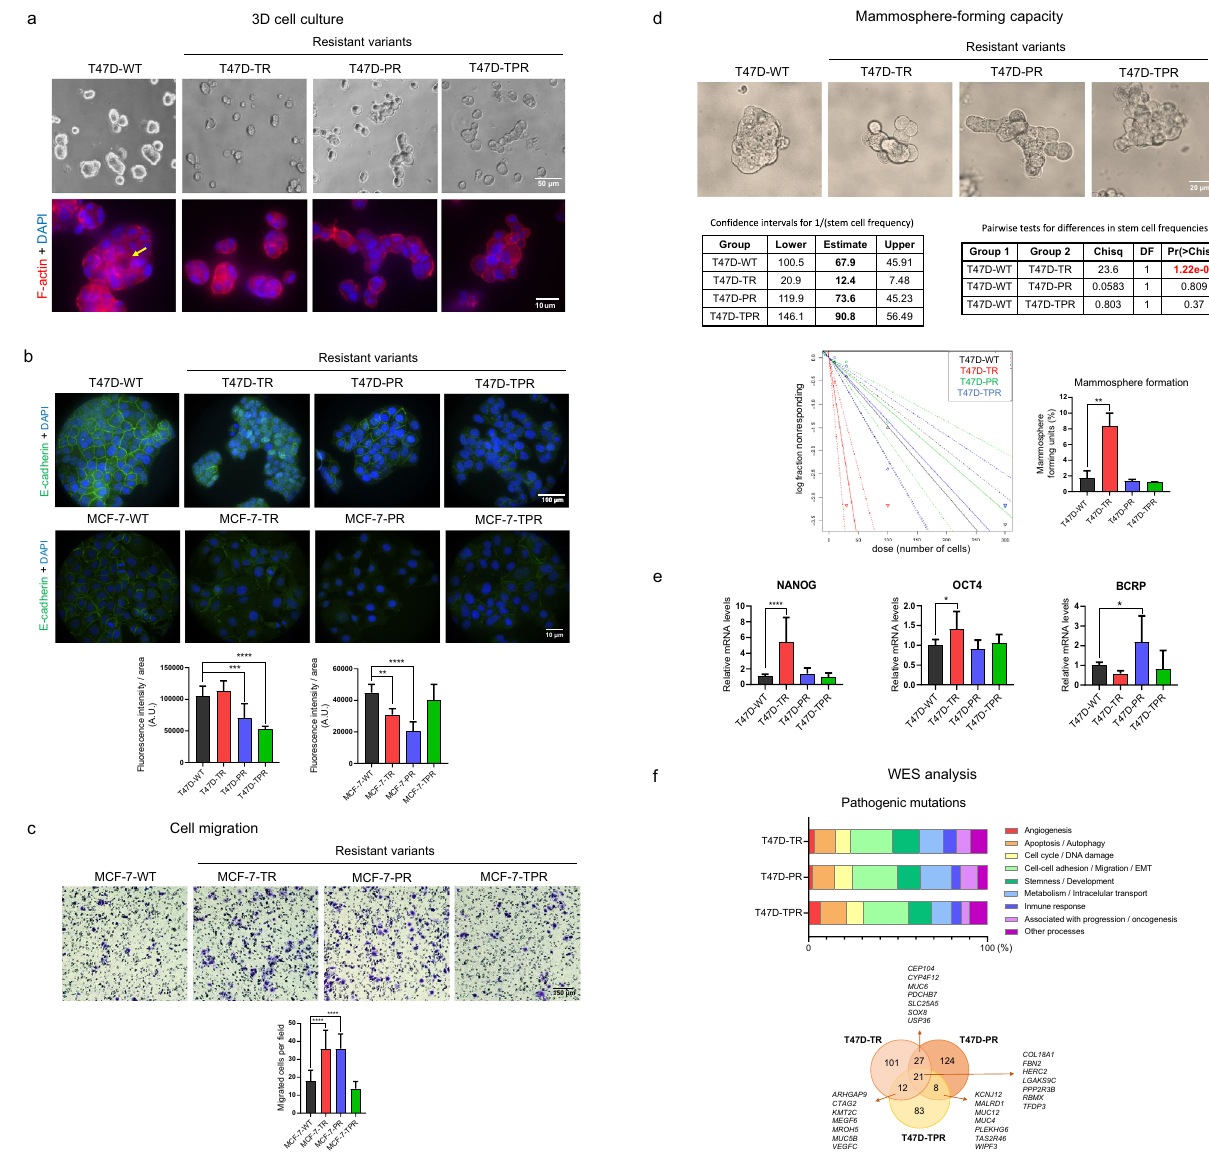
Figure 2. The resistant cells exhibit an altered phenotype. ( a ) 3D cultures. T47D cells were cultured on Geltrex for 48 h. 3D cultures were stained for F-actin with phalloidin (red), and nuclei were counterstained with DAPI (blue). Some of the T47D-WT spheroids exhibited a lumen (yellow arrow). ( b ) Expression and localization of E-cadherin. Confocal microscopy images of immunofluorescence staining for E-cadherin (green). Nuclei were counterstained with DAPI (blue). **p < 0.01, ***p < 0.001. Data represent mean ± SD, one-way ANOVA followed by Dunnett’s test (independent replicates n = 2, with 10 analyzed fields in each group). Since resistant cells are bigger than wild type cells, fluorescence intensity was adjusted to cell area. ( c ) Cell migration. Transwell migration assays were performed by seeding MCF-7 cells onto 8 µm-pore inserts in the presence of a serum gradient. After 24 h, cells that passed through the insert and attached to the other side were quantified. ***p < 0.001. Data represent mean ± SD, one-way ANOVA followed by Dunnett’s test (independent replicates n = 3, with 4 experimental replicates in each group). ( d ) Mammosphere-forming capacity. Mammosphere formation assays and Extreme limiting dilution assay were performed. Sphere formation frequencies were compared using the ELDA web tool (left). The number of cells seeded per well versus the logarithmic fraction of wells without any detected spheres was plotted (middle). Trend lines represent the estimated active cell frequency, dotted lines show the 95% confidence interval. Percentage of sphere-forming units was plotted according to % = 1/Frequency × 100 (right). **p < 0.01. Data represent mean ± SD, one- way ANOVA followed by Dunnett’s test (independent replicates n = 2, with 6 experimental replicates in each group). ( e ) Expression of stemness markers. mRNA levels of NANOG, OCT4 and BCRP were measured by qRT-PCR. Expression levels were normalized to the GAPDH expression for each variant. *p < 0.05, ****p < 0.0001. Data represent mean ± SD, one-way ANOVA followed by Dunnett’s test (independent replicates n = 3, with 3 experimental replicates in each group). ( f ) Pathogenic mutations in T47D-resistant cells. Mutations that were not present in the parental cells were filtered by potential pathogenicity using REVEL, SIFT, Polyphen2 and CLNSIG predictors. Top: Mutated genes were grouped according to their function or the cellular processes they are involved in. Bottom: Venn Diagram showing the number of pathogenic mutations in the resistant cells and some relevant mutated genes. Original images are presented in Supplementary Material, unprocessed photomicrographs